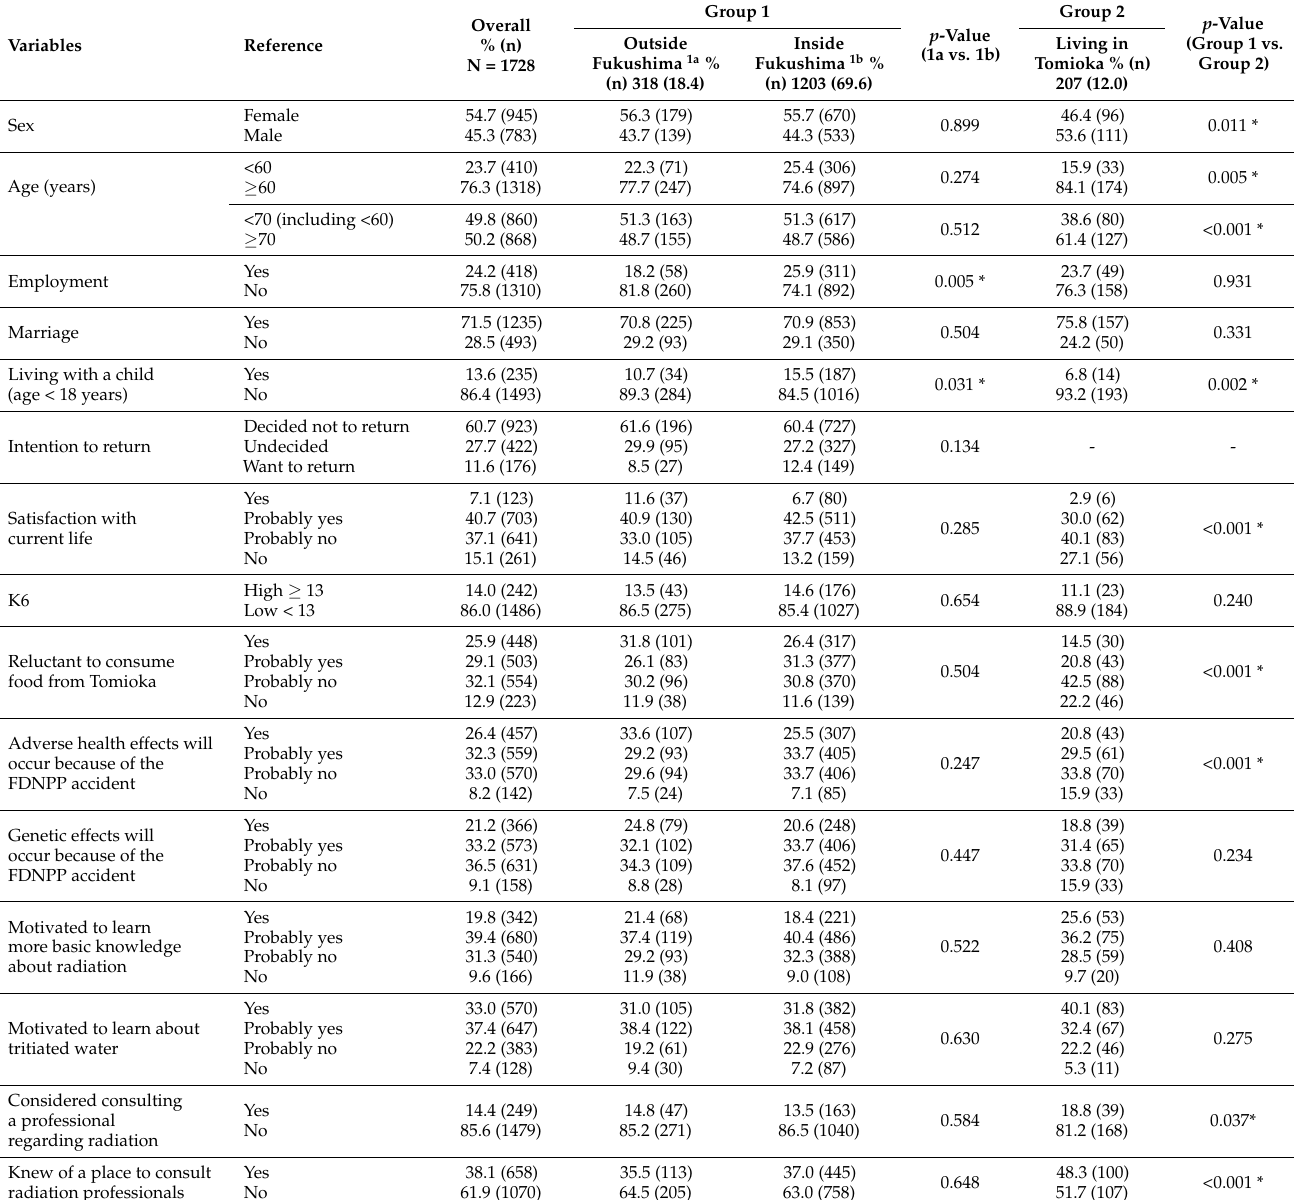
Table 1. Sociodemographic characteristics of the study participants by area of